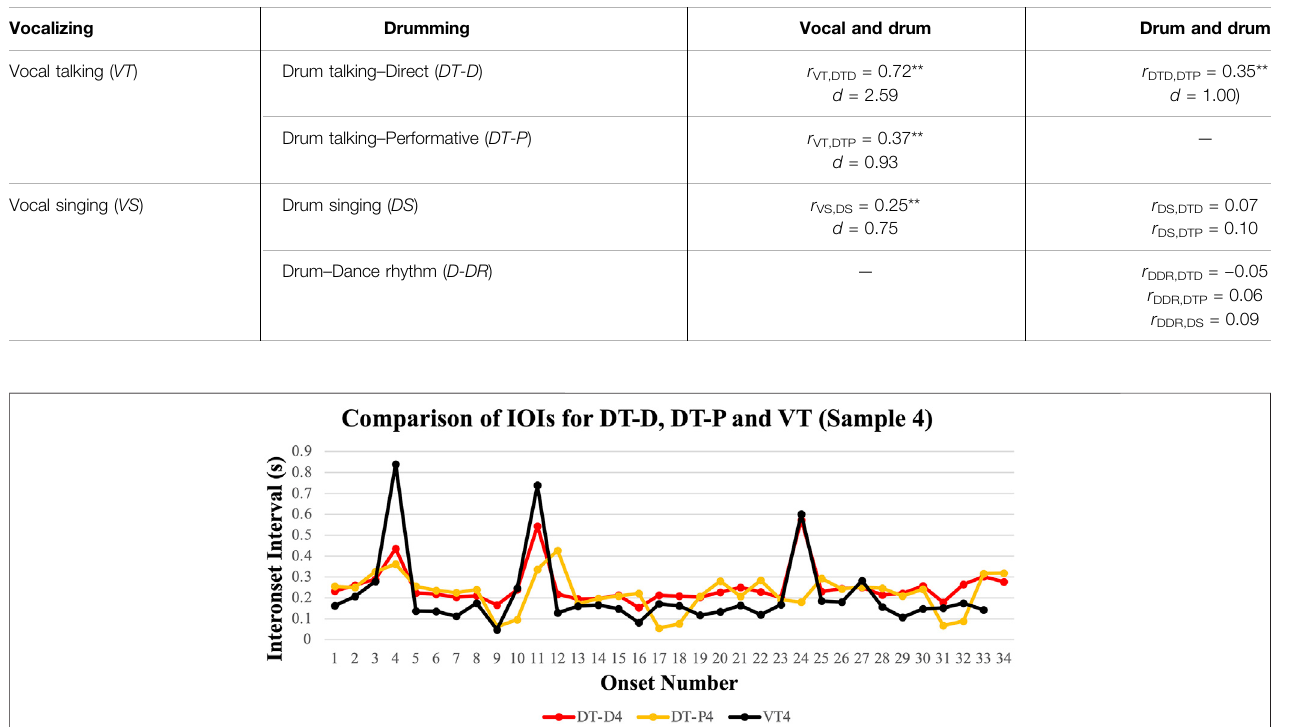
FIGURE3| Interonsetintervals(IOIs) foratypicalvocaltalking(VT)sampleandcorrespondingimitations ofthespeechsequenceonthedrum, bothdirectimitation (DT-D) and while musically performing the speech sequence (DT-P). Syllabic and drum onsets are presented as a monotonic temporal series on the X -axis, and the duration of each onset is indicated on the Y -axis. Thus, shorter IOIs correspond to lower values and longer durations correspond to higher values. Signi fi cant peaks represent gaps between sub-phrases. Note how the DT-D timing pro fi le closely resembles VT, aligning robustly at the IOI peaks between sub-phrases, while the useofrhythmicembellishmentsinDT-Presultsinasomewhatlessrelatedtimingpro fi lethanthatofVTandDT-D(seesoundsamples SupplementarySamples1A – C